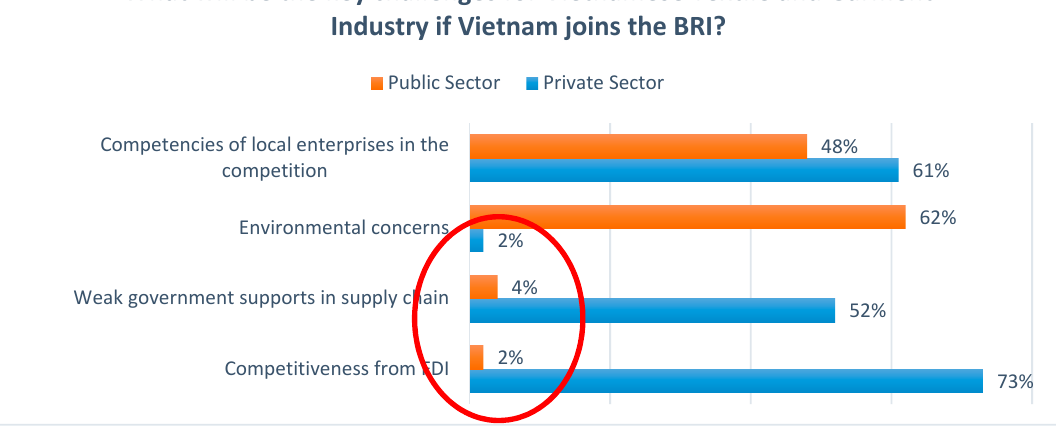
Figure 6. Competencies to be more competitive in an international playing field is the key challenge (Source: Authors’ analysis).